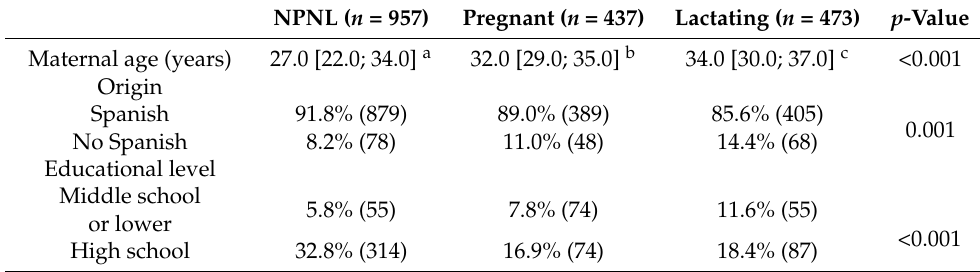
Table 1. Cohort sociodemographic characteristics by